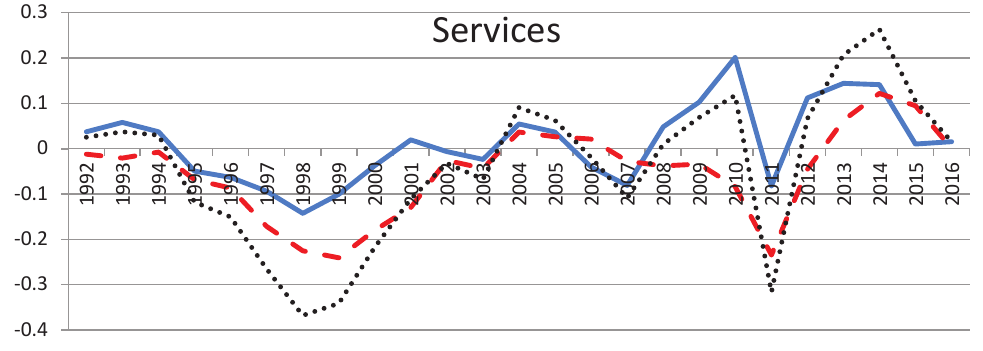
Source: own calculations on INPS data. Note: this figure plots the results on composition effects obtained from the BO decomposition (this is therefore the part of aggregate wage dynamics explained by changes in the average characteristics of employed individuals in the economy and of the firms where they are employed, keeping returns to these character- istics fixed over time). The results report the ratio between the 3-year moving average of the part of aggregate wage growth explained by changes in workers’ and employers’ compo- sition and the 3-year moving average of aggregate wage growth. The blue line refers to the share of the yearly change in wage levels explained by changes in workers’ characteristics, and the red line refers to the share of the yearly change in wage levels explained by changes in employers’